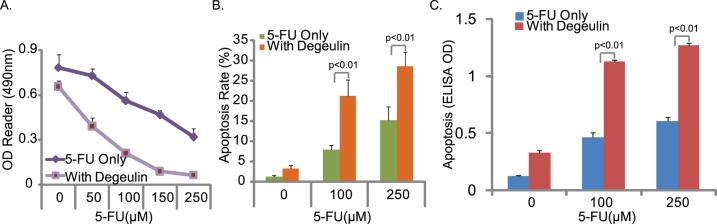
Low dose of deguelin sensitizes Hep-2 cells to 5-FU.Hep-2 cells were exposure with the indicated concentration of 5-FU in the presence or absence of deguelin (10 µM), MTT assay was used to test cell viability after 72 hours (A), Hoechst 33342 nuclear staining (B) and enzyme-linked immunosorbent cell apoptosis assay (C) were used to test cell apoptosis after 48 hours. The mean of at least three independent experiments performed in triplicate is shown. Statistical significance was analyzed by ANOVA.